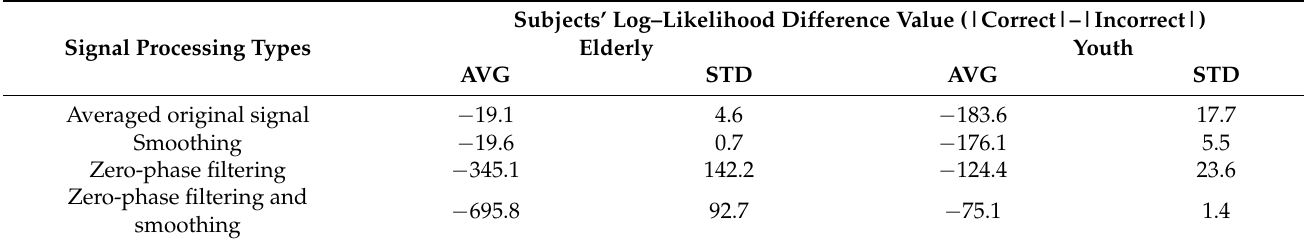
Figure 11. Log–likelihood result of original signal: It is difficult to distinguish the data of the elderly without signal processing. Table 4. Comparison log–likelihood analysis result through GMM modeling of signal correct answer: The better the classification between correct answer and incorrect answer, the smaller the